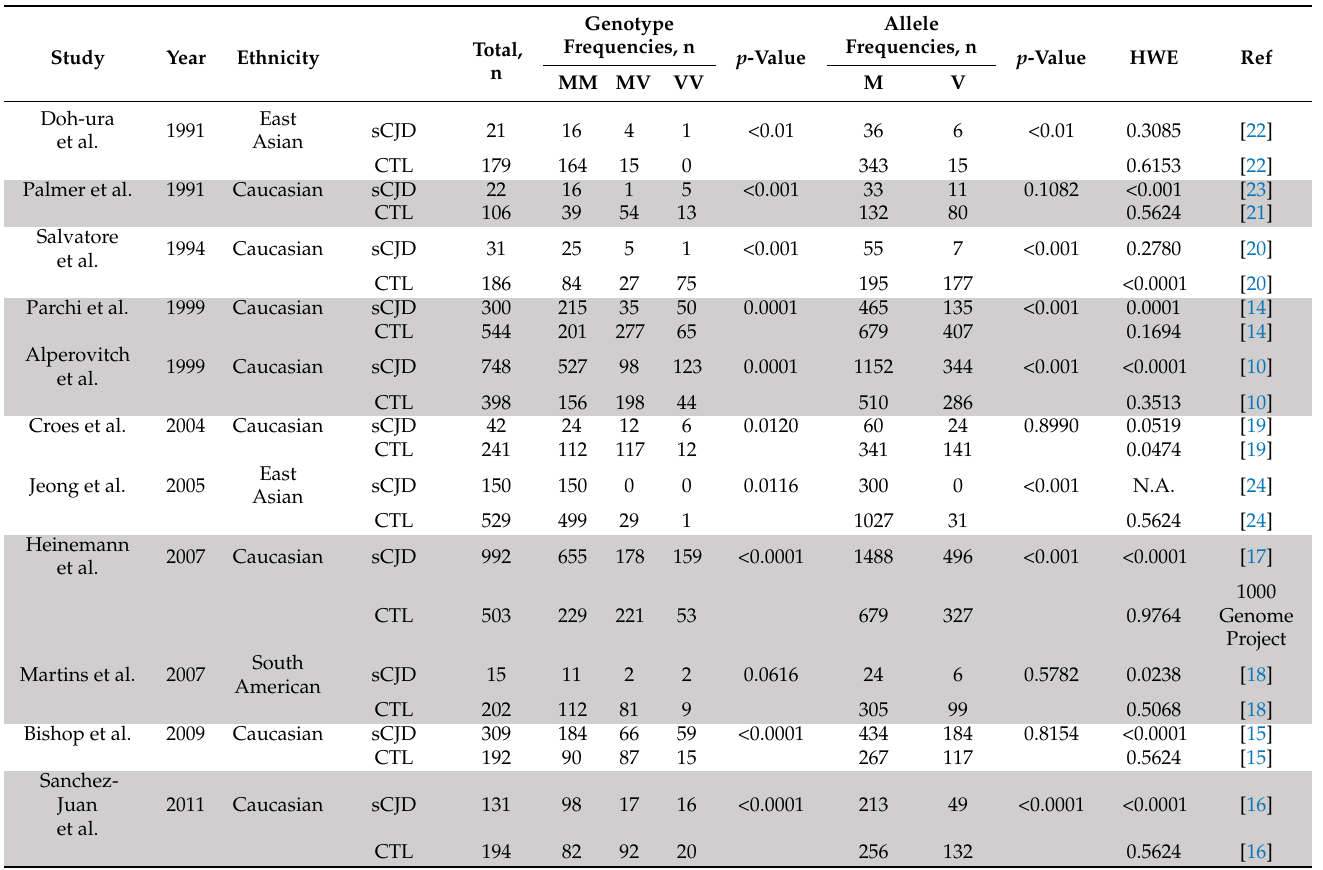
Table 1. Comparison of the genotype and allele frequencies of M129V in the prion protein gene ( PRNP ) between sporadic Creutzfeldt–Jakob disease (sCJD) patients and matched control populations (CTL) in previous studies.